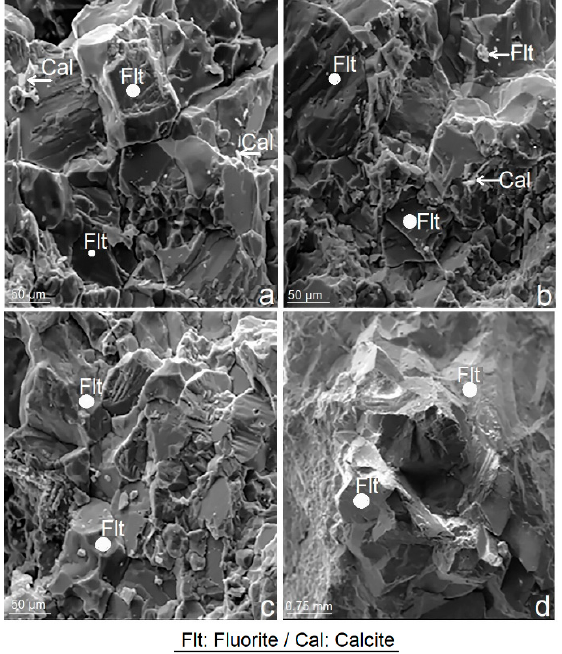
Figure 3. Microphotographs ( a – d ) of the investigated natural fluorite sample without banding.